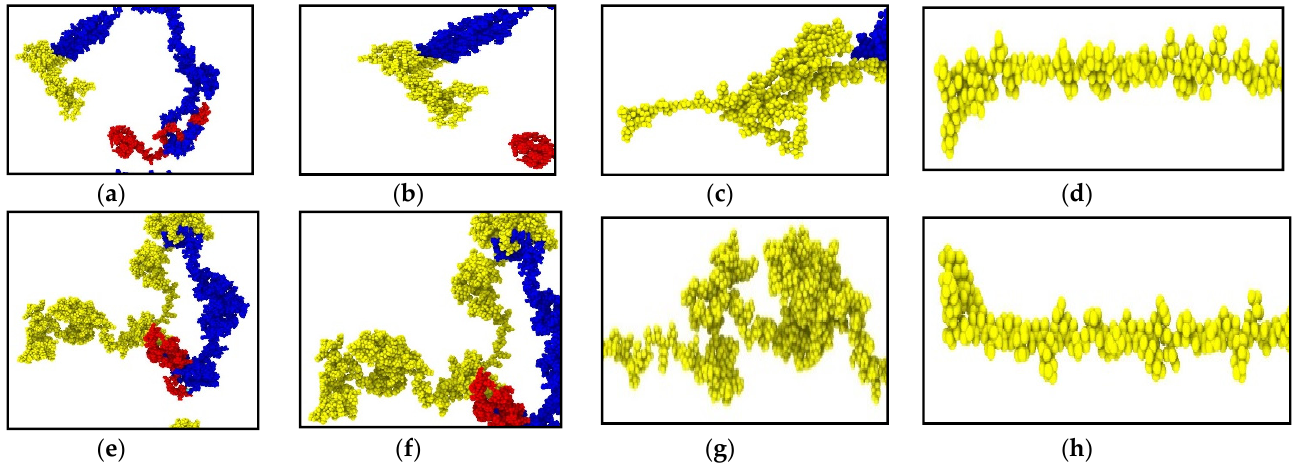
Figure 2. Stress–strain graphs at two different strain rates for the pulled tail domain of ( a ) NFL and ( b ) NFH. Throughout the pulling process, we can observe simultaneous unfolding and stretching, and therefore, these two domains cannot be distinguished. However, NF acts as a stiffer material under the application of higher stress as depicted by the steeper slope at higher strain rate. In order to make a reasonable compromise with the computational cost, we have stopped at ~220% strain for lower strain rate, which we assumed to be sufficient to capture stretched state, while for higher strain rate, we have recorded result till ~360% strain.